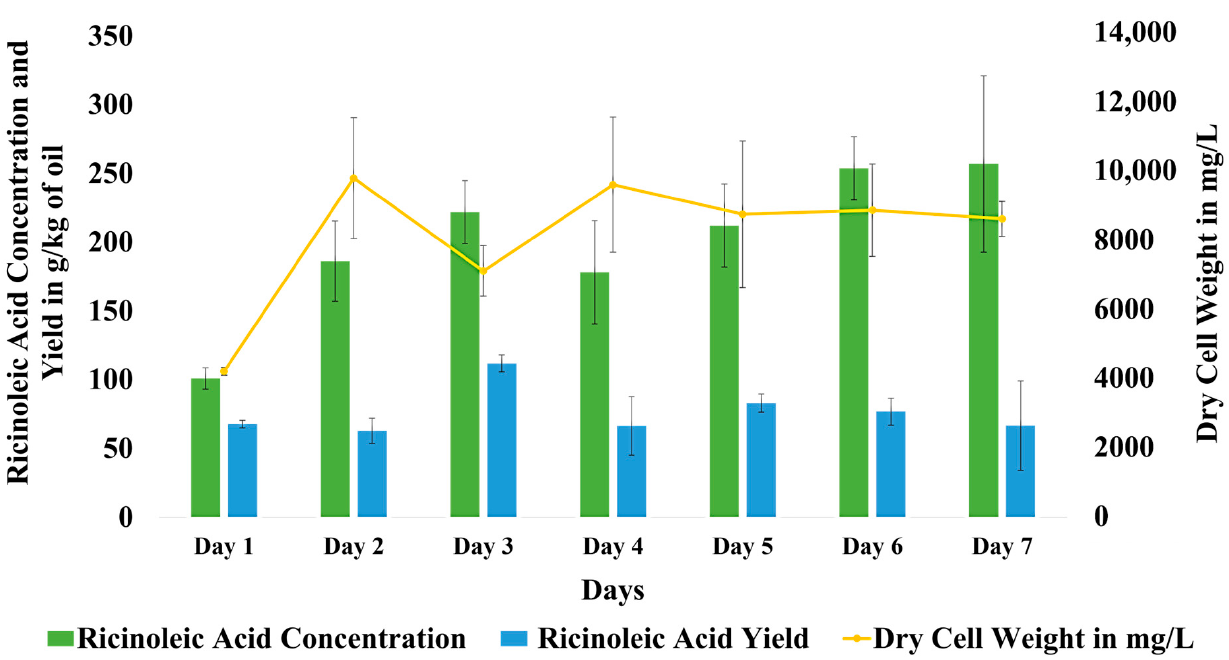
Figure 3. Graph representing ricinoleic acid concentration and yield, along with the Dry Cell Weight of the A. flavus BU22S with time.